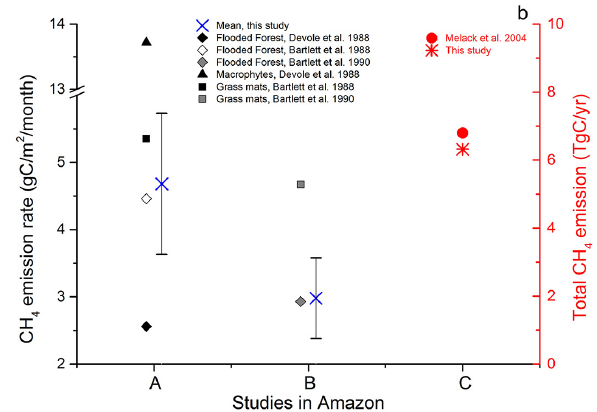
Figure 5b. Comparisons between simulation results of mean (cross symbol) ± 1SD (short bar) and observations from studies of A: Devol et al. (1988) and Bartlett et al. (1988), and B: Bartlett et al. (1990); C: total annual CH 4 emission comparison between sim- ulation and the study of Melack et al. (2004) in the